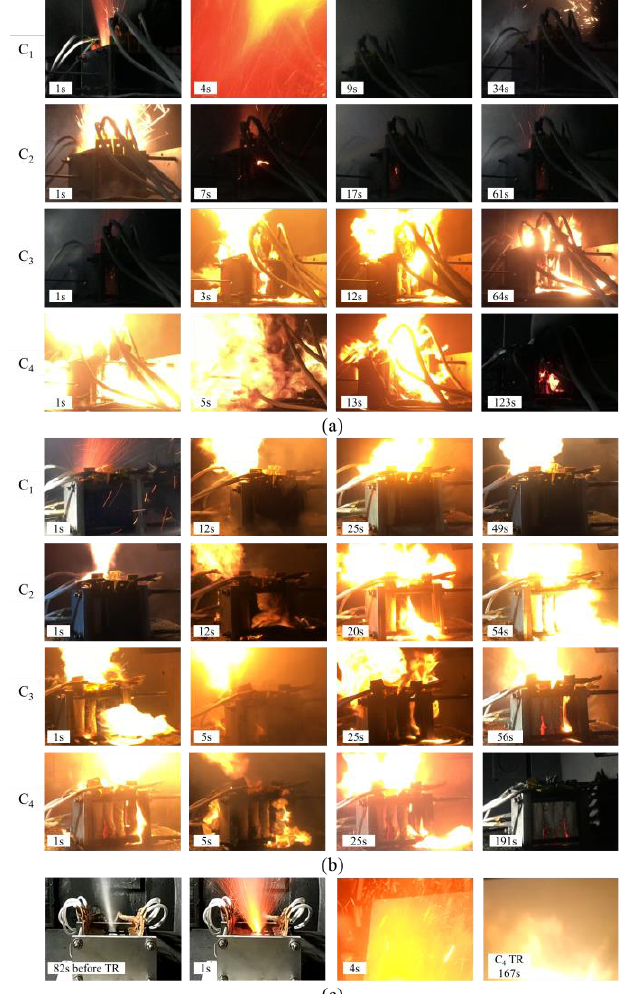
Figure 13. TRP phenomena with different abuse methods. ( a ) Nail penetration; ( b ) Side heating; ( c ) Overcharge.